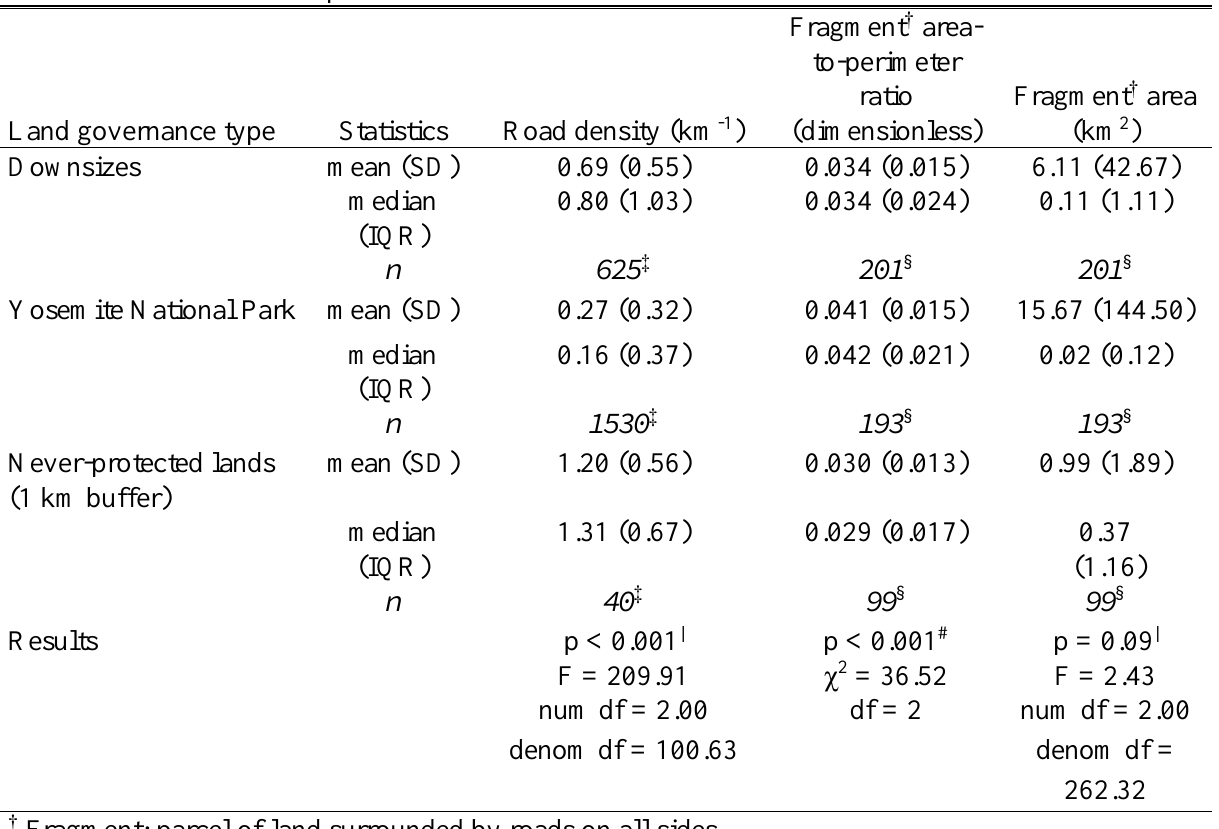
Table A1.10: Habitat fragmentation indicators for all land cover types at the Park scale. See Table A1.11 for results of post-hoc